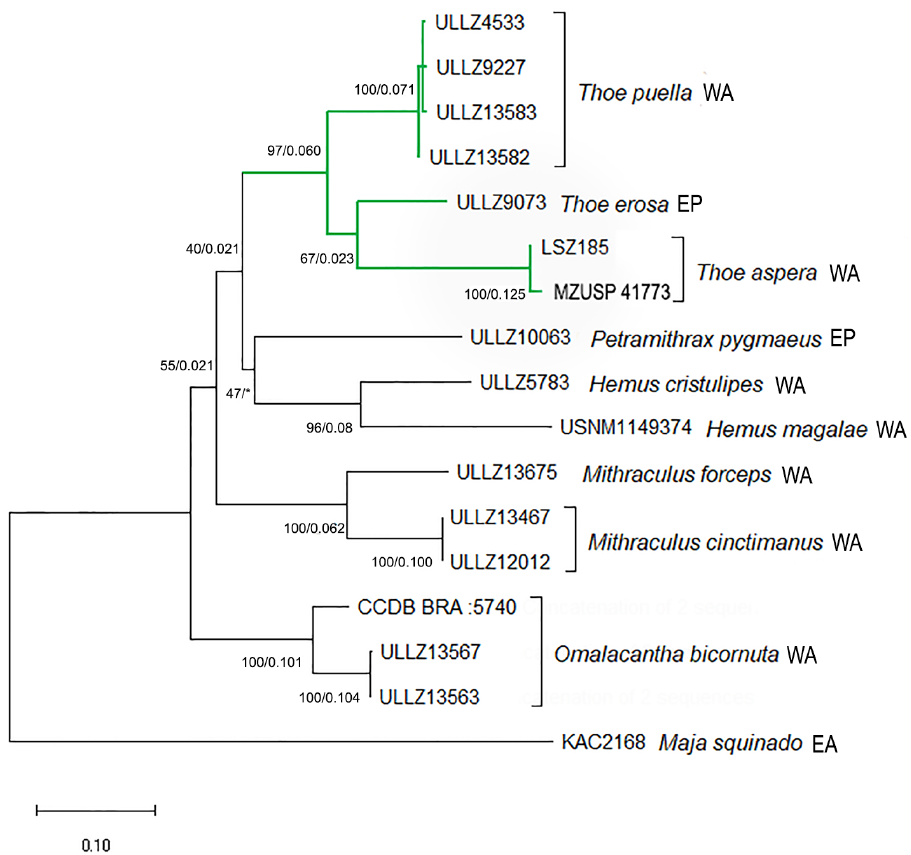
Figure 1. Molecular phylogenetic tree represented as maximum likelihood and Bayesian topology of two partial mitochondrial (COI and 16S) sequences showing Thoe inter- and intra-generic relationship, based on 5 close genera and 17 sequences including Maja squinado as outgroup with maximum likelihood bootstrap values and Bayesian posterior probabilities (* different topology). Note: ULLZ 9227 of Windsor and Felder (2014) reidentified as Thoe puella Stimpson, 1860